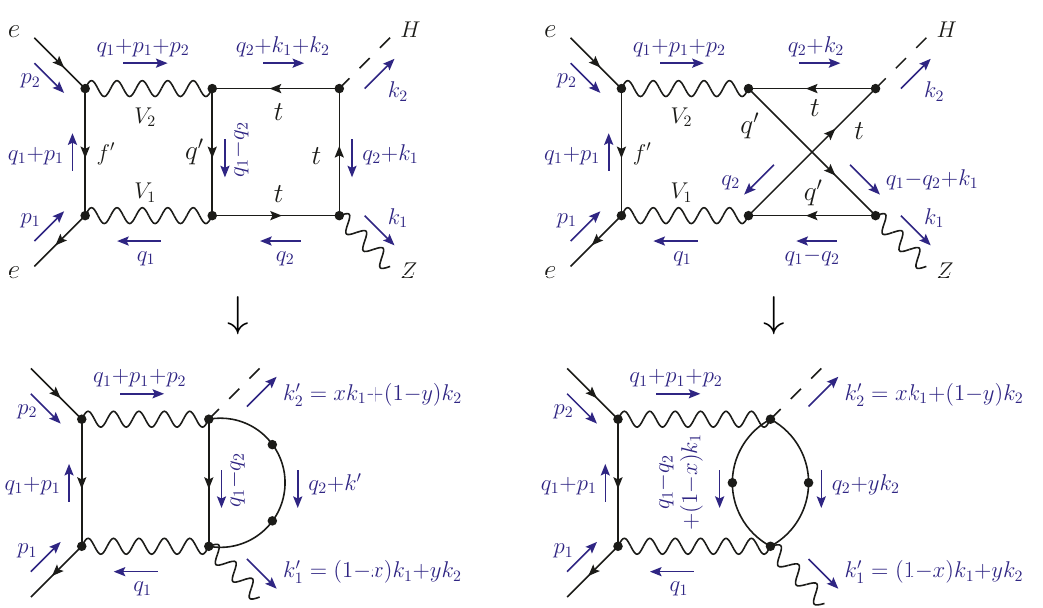
Figure 1. Planar (left) and non-planar (right) two-loop box diagrams with top quarks in the loop. The bottom row visually illustrates the effect of introducing Feynman parameters for the top loop. If V 1 , 2 = γ, Z then f 0 = e , q 0 = t , whereas f 0 = ν e and q 0 = b for V 1 , 2 = W